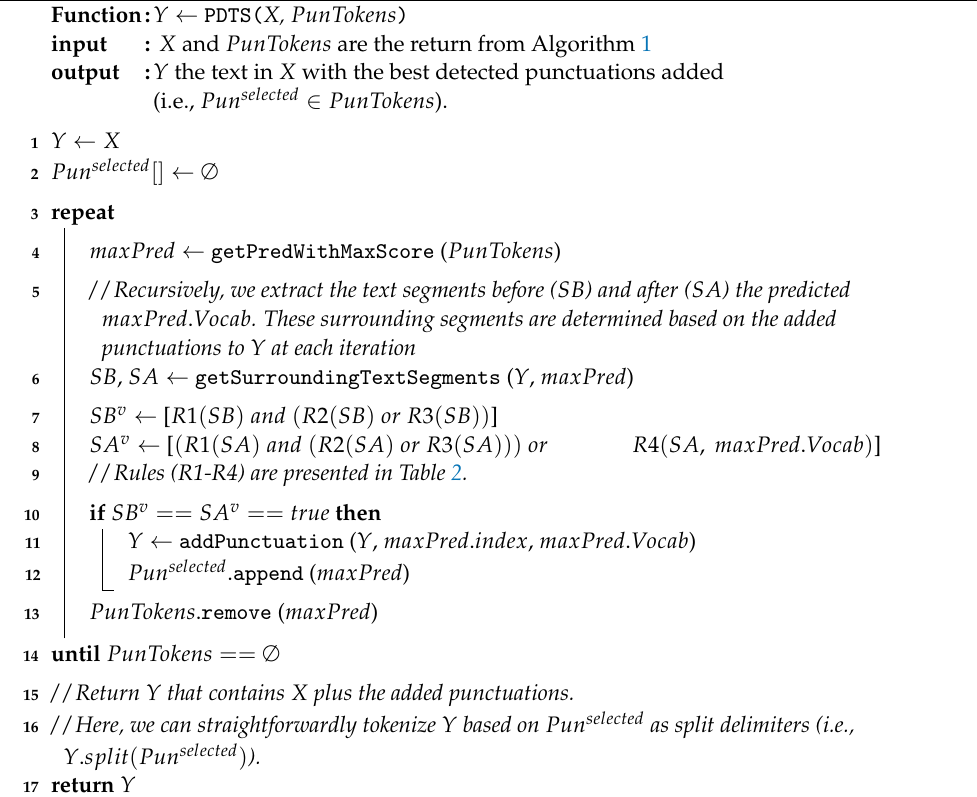
Algorithm 2: The proposed procedure for validating the predicted punctuations in Algorithm 1 and selecting the best ones to be added in X . These added punctuations can be then used as split delimiters for segmenting X